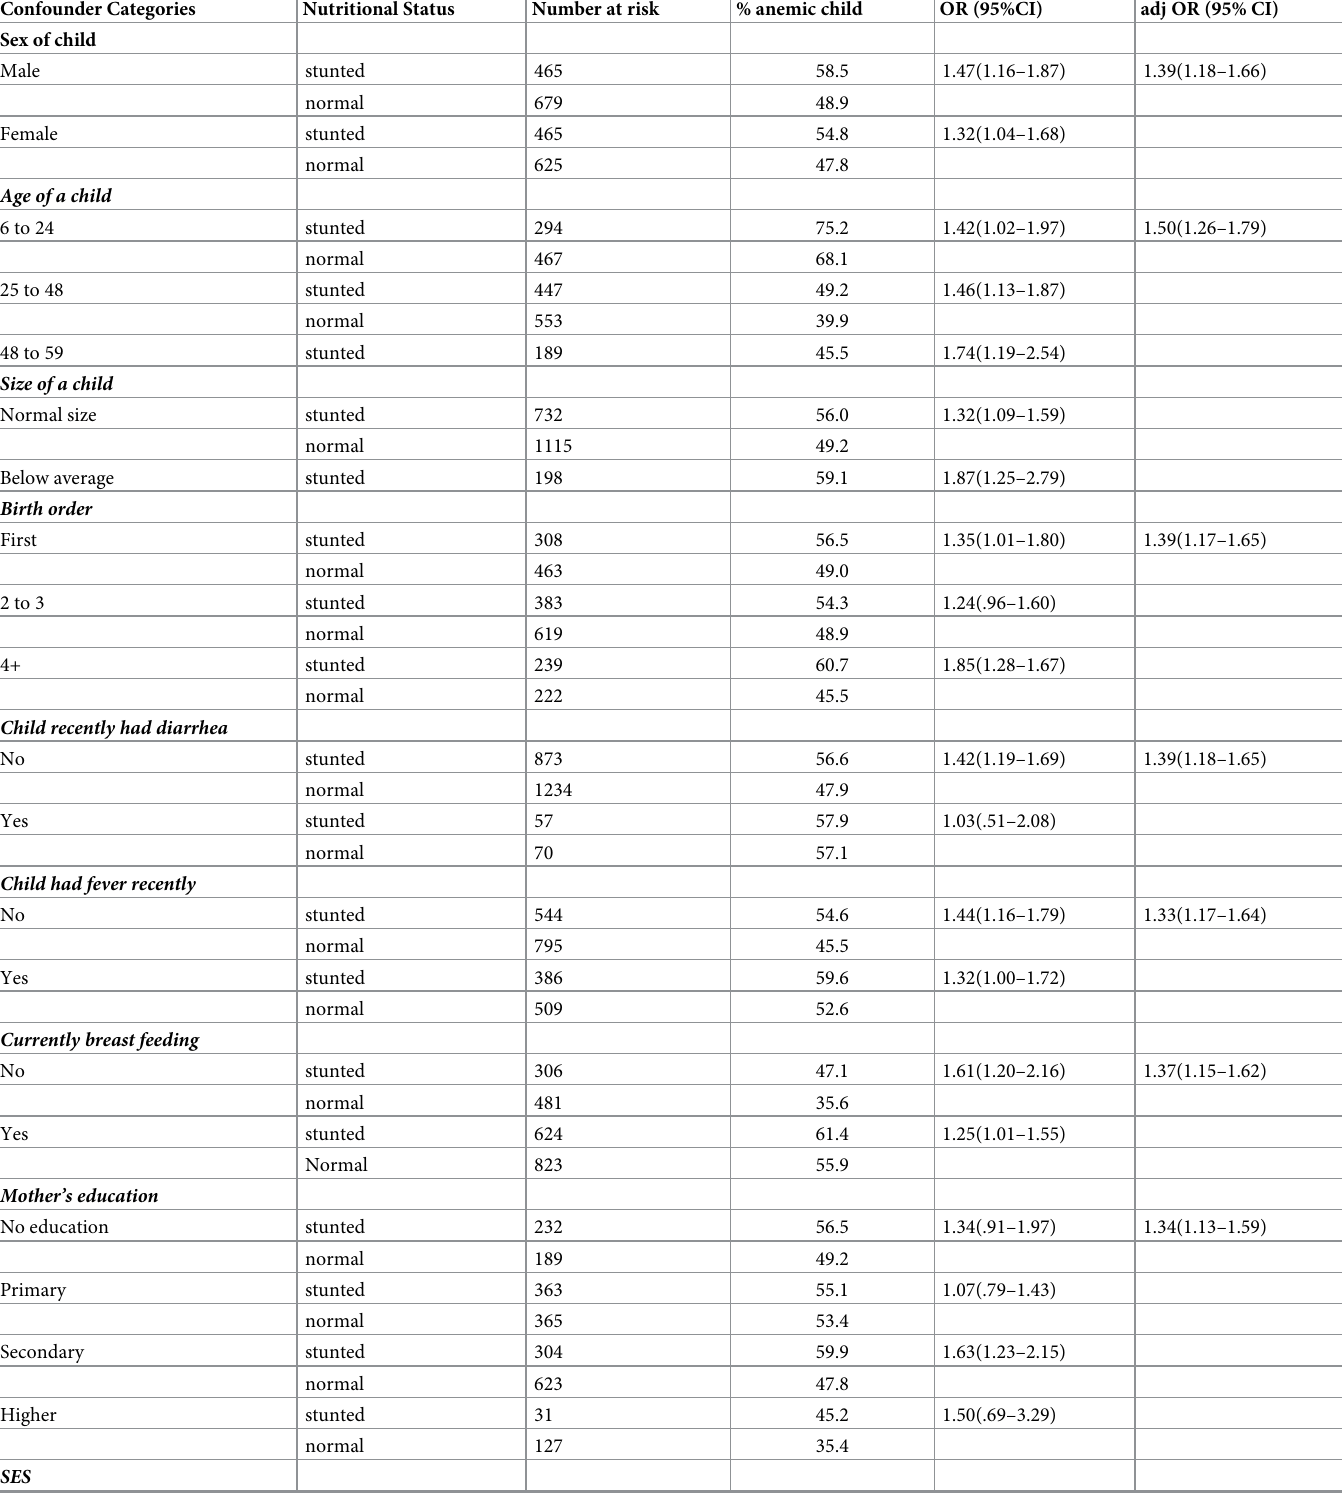
Table 3. Association between stunting and anemia in children of age 6–59 months. Confounder